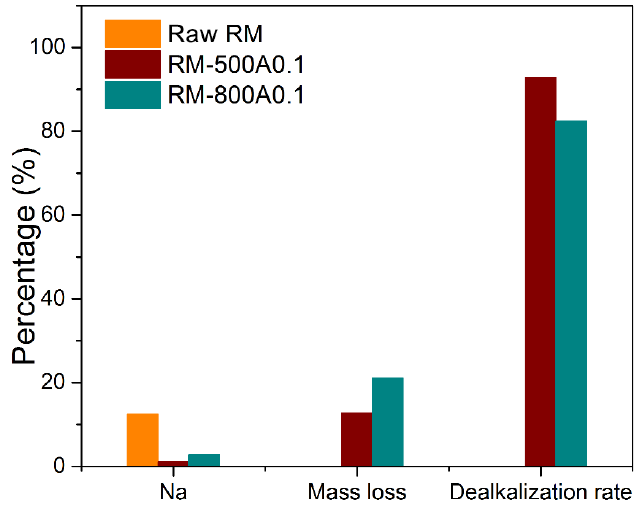
Figure 9. The Na content, mass loss, and dealkalization rate of three samples. The schematic diagram of the diluted acid leaching strategy is shown in Figure 10. Table 3. The chemical composition, weight loss, and the dealkalization rate of samples (wt.%).